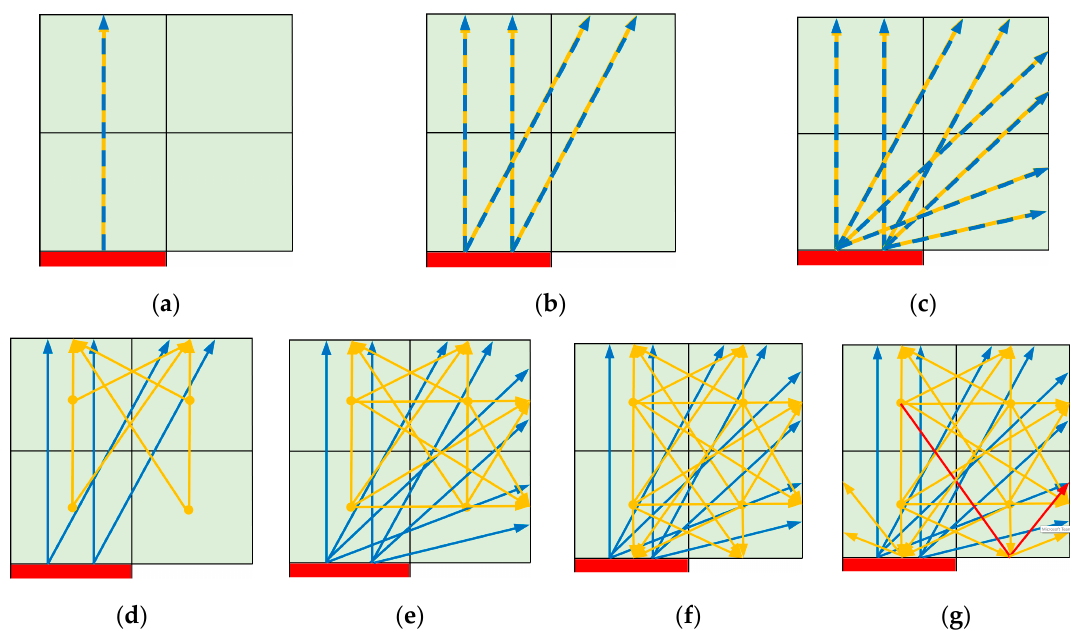
Figure 24. Different strategies of modeling light propagation, tested in our CoB simulations: ( a ) 1D; ( b ) general rays to top; ( c ) general rays to top and sides; ( d ) general + yellow rays to top; ( e ) general + yellow rays to top and sides; ( f ) general + yellow rays to all phosphor sides; ( g ) general + yellow rays to all sides with bottom side reflection. (One of the reflected yellow rays was highlighted in red).